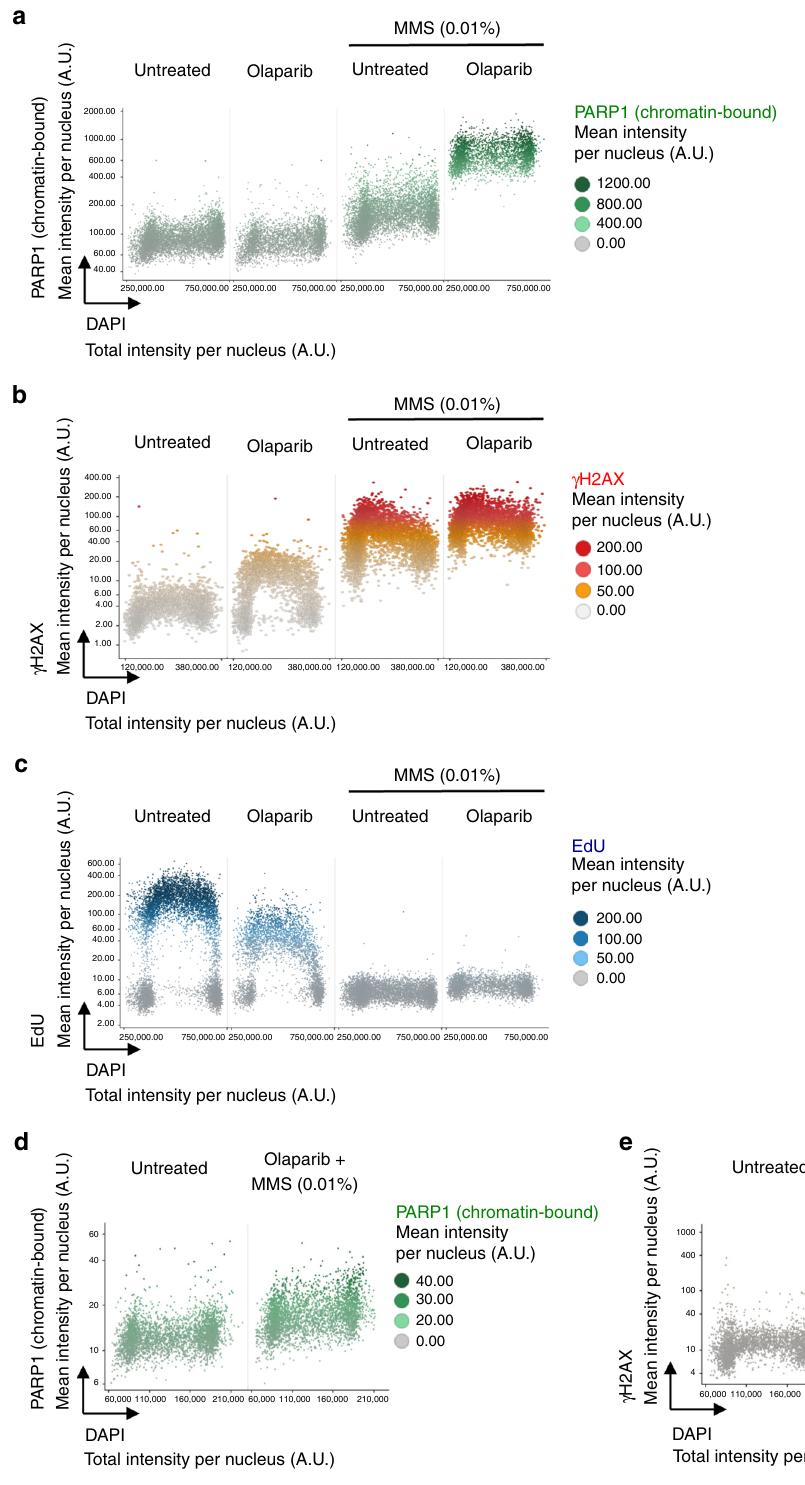
Fig. 3 Image-based quanti fi cation of PARPi-induced PARP1 trapping. a U-2 OS cells were treated with 10 μ M olaparib and 0.01% MMS for 4 h as indicated, pre-extracted on ice in 0.2% Triton X-100 for 2 min to remove soluble, non-chromatin-bound proteins, and stained for PARP1, γ H2AX and DNA content. Chromatin-bound PARP1 levels were quanti fi ed and are depicted as a function of cell cycle progression. b For the same cell populations, γ H2AX levels were quanti fi ed and are depicted as a function of cell cycle progression. c For the same cell populations analyzed in a and b two-dimensional cell cycle pro fi les based on DAPI/EdU are shown. d Cells were treated with 10 μ M olaparib and 0.01% MMS for 1 h, pre-extracted on ice in 0.2% Triton X-100 for 2 min to remove soluble, non-chromatin-bound proteins, and stained for PARP1, γ H2AX and DNA content. Chromatin-bound PARP1 levels were quanti fi ed and are depicted as a function of cell cycle progression. e For the same cell populations, γ H2AX levels were quanti fi ed and are depicted as a function of cell cycle progression. Color codes as de fi ned in the fi gure